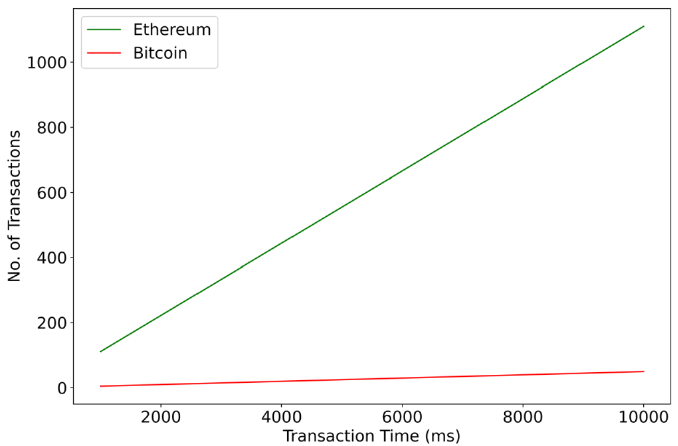
Figure 12. Scalability